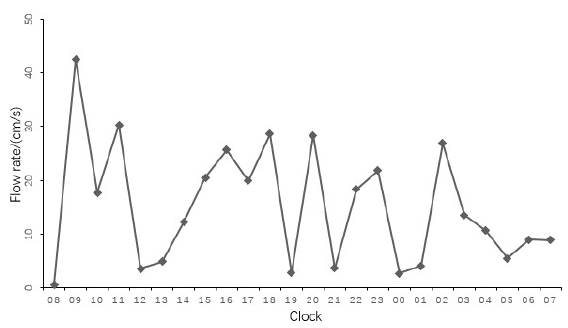
Figure 4. Flow chart of sea current flow rate with